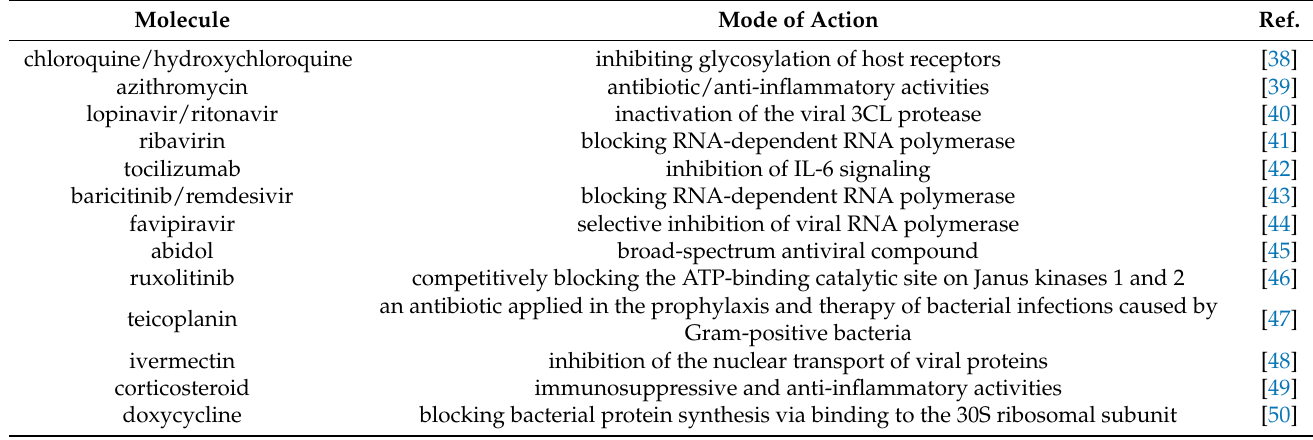
Table 1. Some of the identified molecules and compounds with antiviral activity. Mode of Action